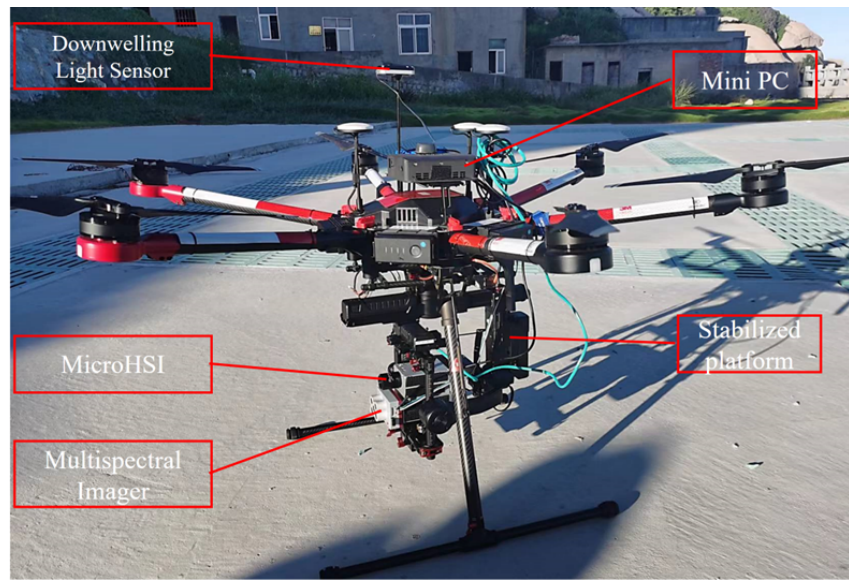
Figure 1. Photograph of UAV imaging